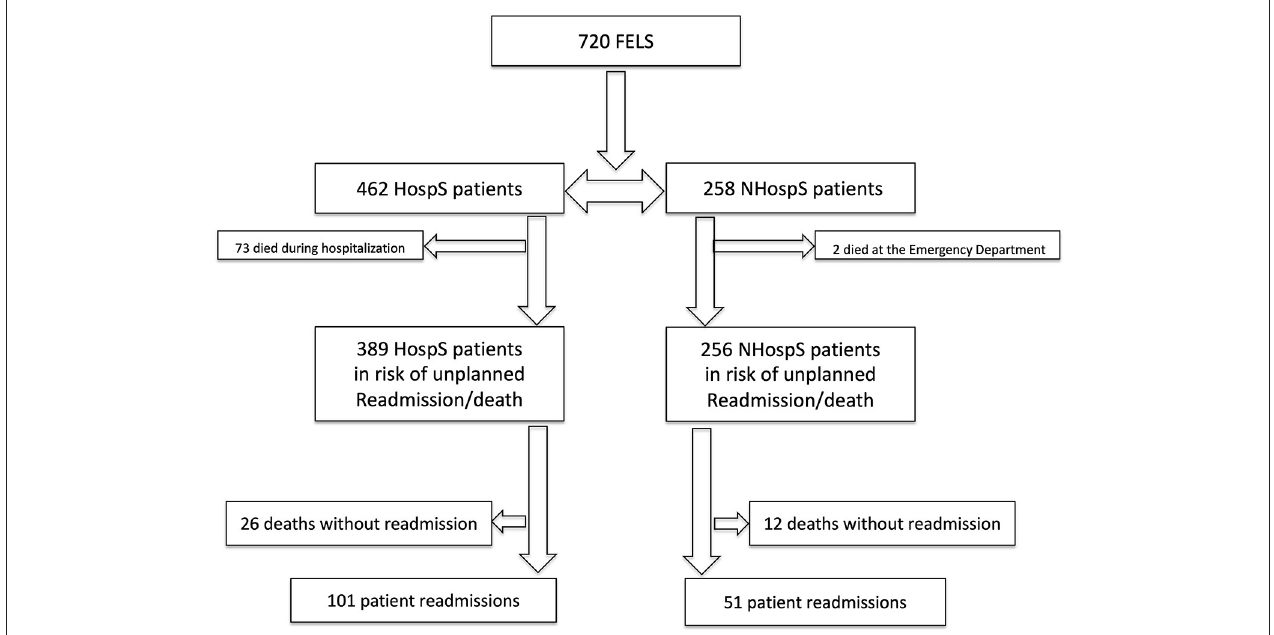
FIGURE 1 | Study design for cohort follow-up. FELS, first-ever-in-a-lifetime stroke; HospS, hospitalized stroke patients; NHospS, non-hospitalized stroke patients.